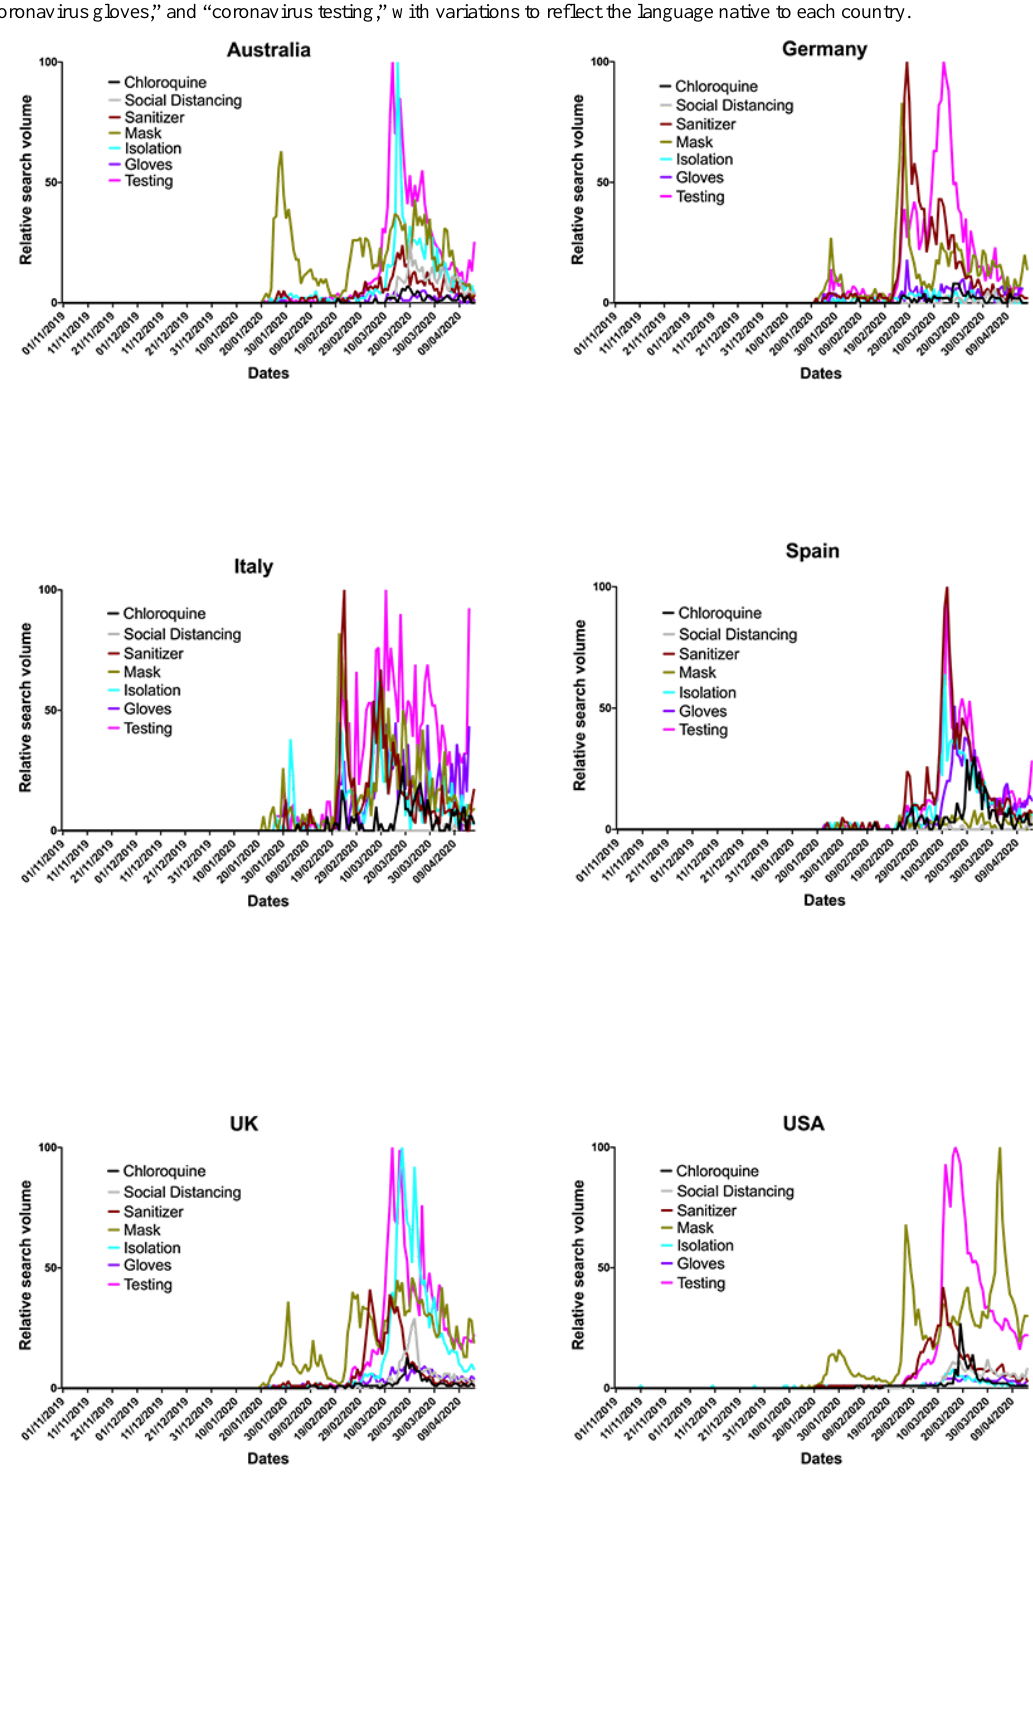
Figure 5. Government policy relative search volumes (RSVs) extracted from Google Trends (GT). Grouped RSV data, normalized to the highest RSV peak in the time period (represented as 100) were extracted from GT on April 17, 2020, for the period of November 1, 2019, to April 17, 2020. Search terms included “coronavirus chloroquine” (control term), “coronavirus social distancing,” “coronavirus sanitizer,” “coronavirus mask,” “coronavirus isolation,” “coronavirus gloves,” and “coronavirus testing,” with variations to reflect the language native to each